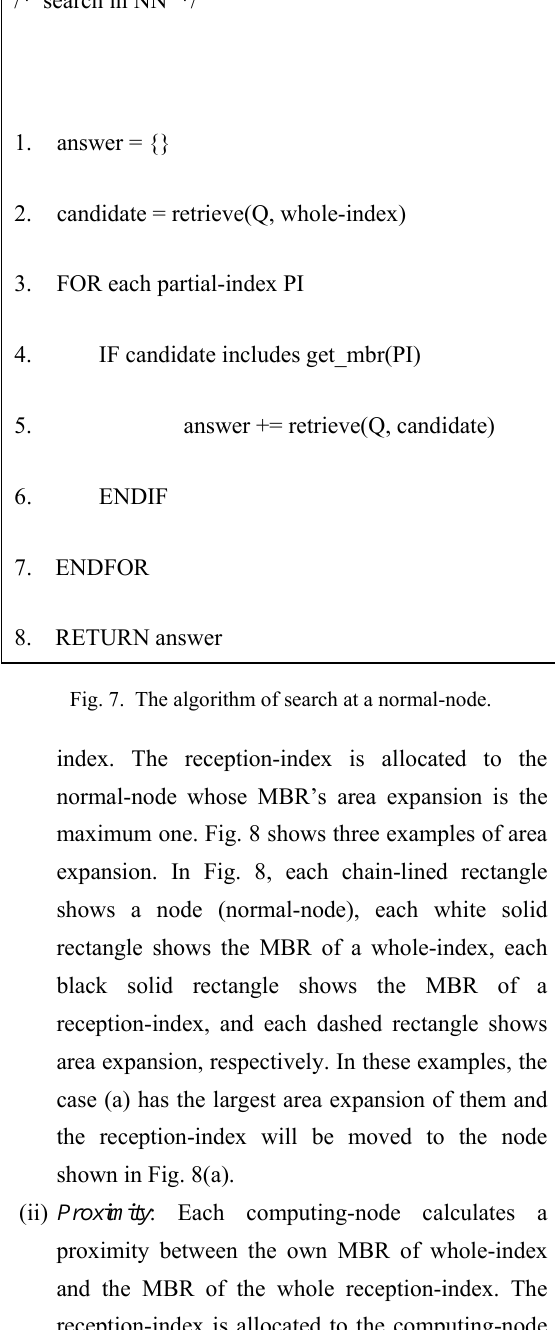
Fig. 6. The algorithm of search at a representative-node.